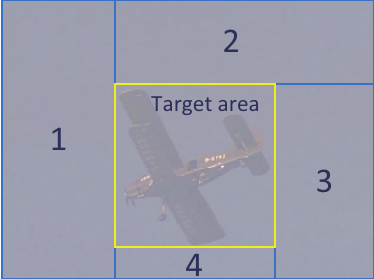
Figure 12. The image is divided into five blocks.